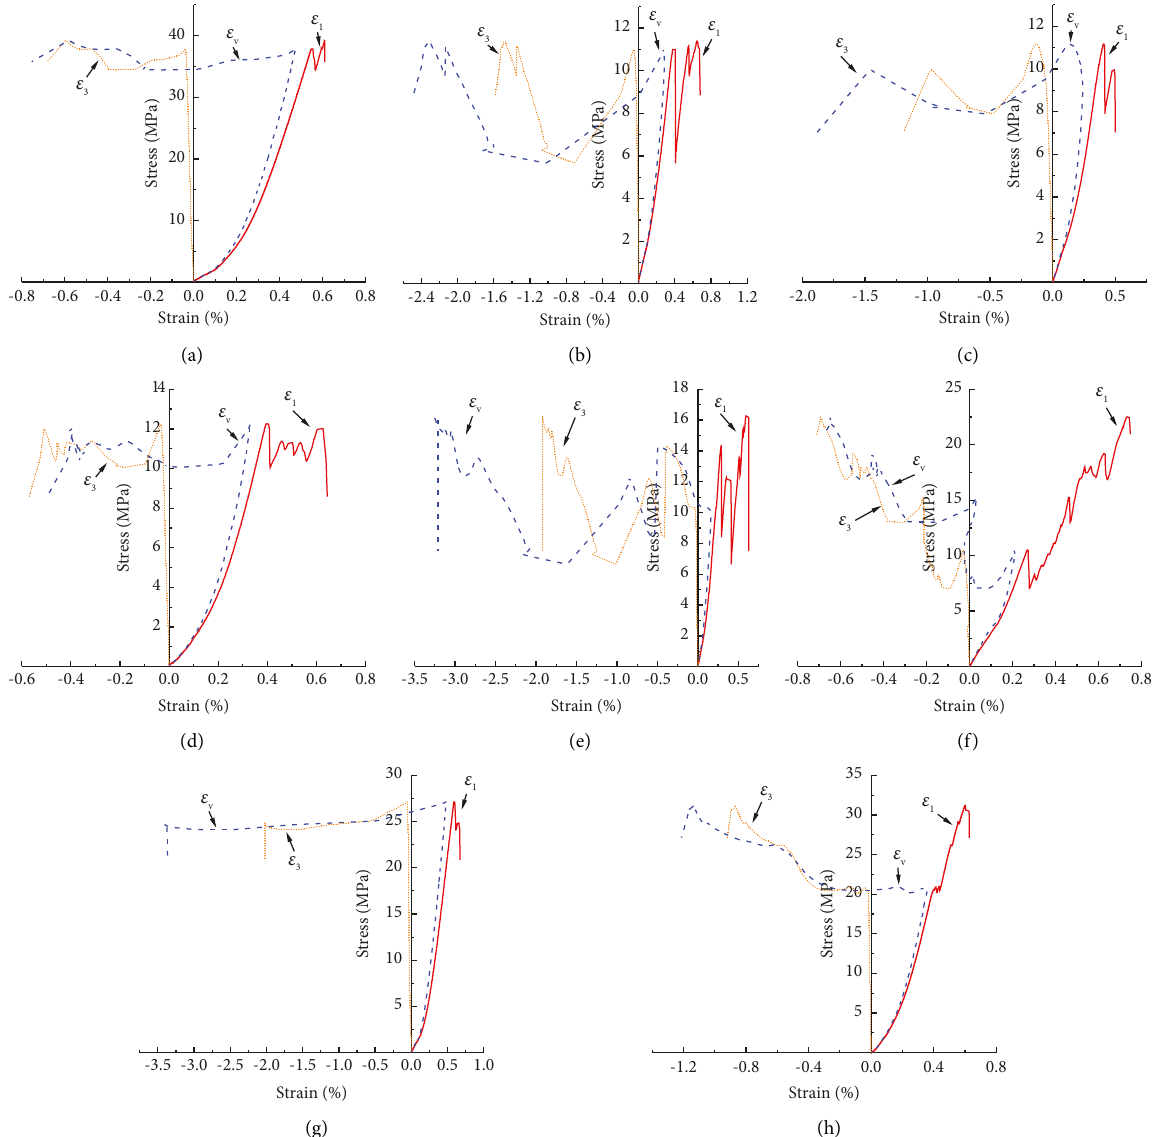
Figure 2: Conventional uniaxial compression stress-strain curves of fissured sandstone with different dip angles. (a) A-intact. (b) A-0. (c) A- 15. (d) A-30. (e) A-45. (f) A-60. (g) A-75. (h)